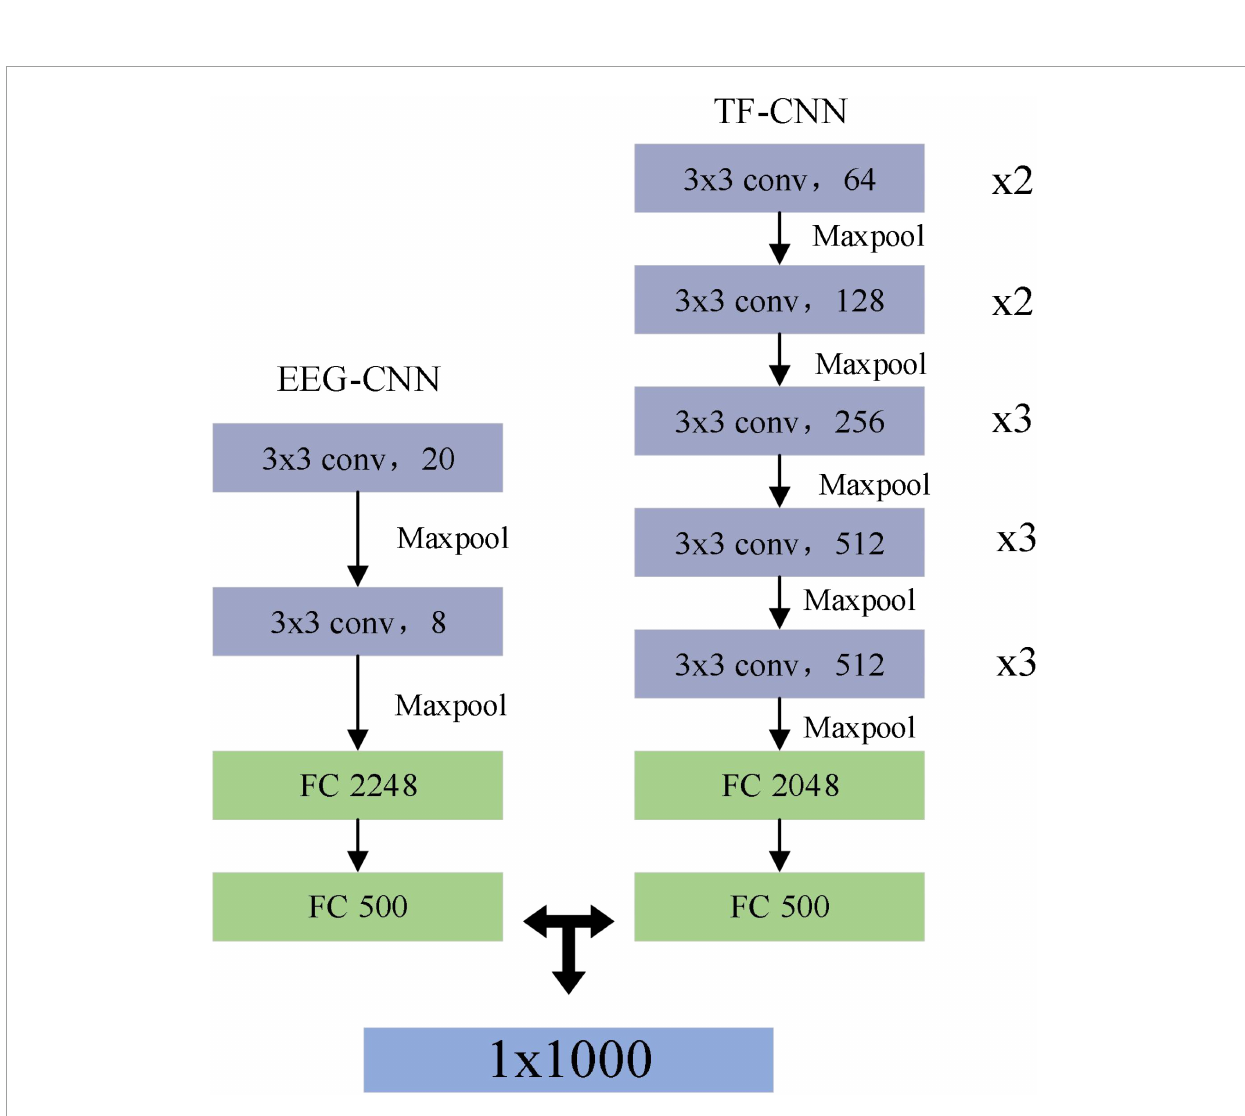
FIGURE4 Structure of multi-branch fusion convolutional neural network (MF-CNN) model.